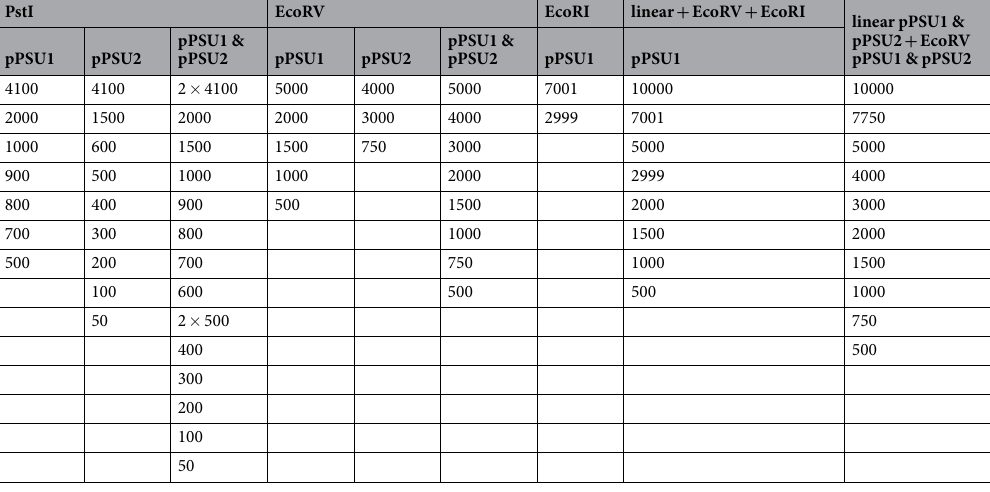
Table 1. DNA ladder fragments from pPSU1 and pPSU2